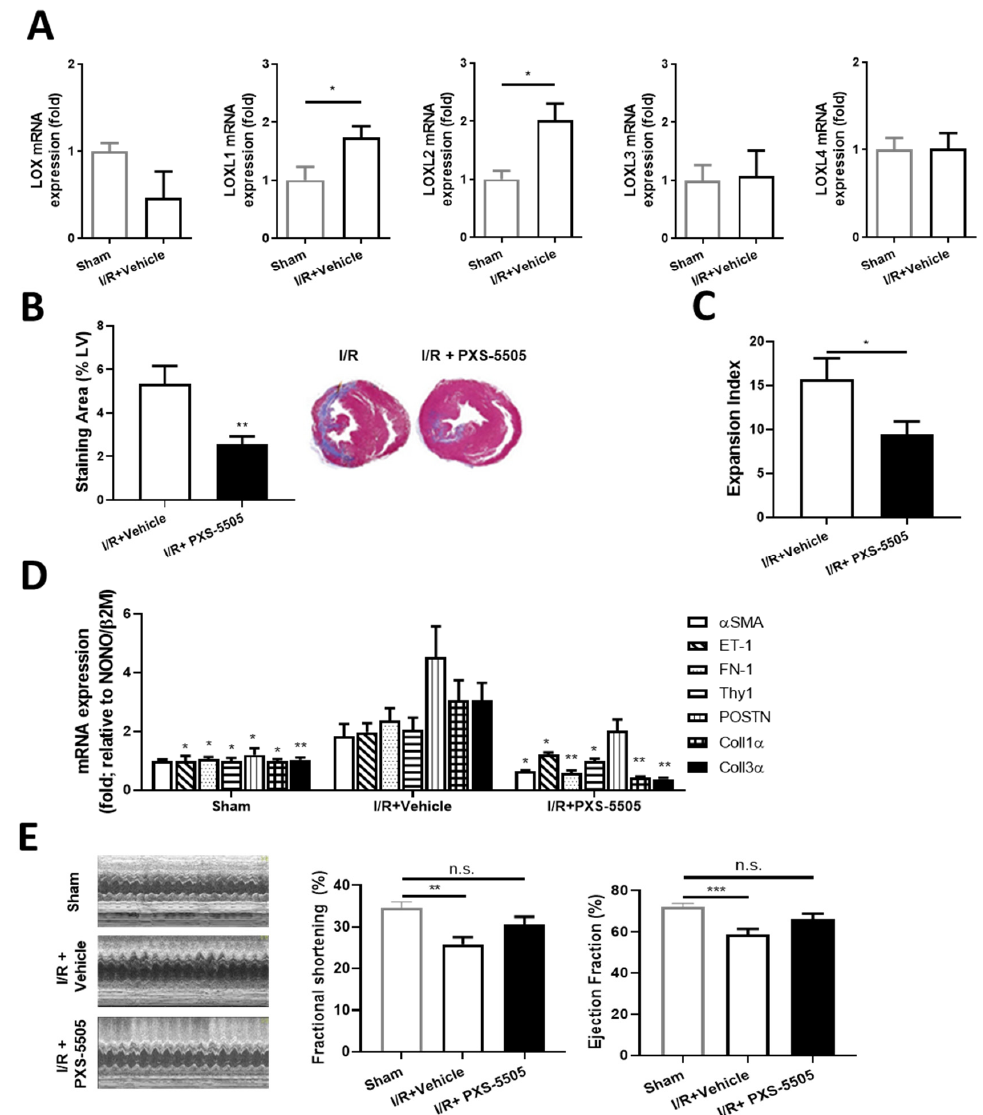
Figure 5. Effect of PXS-5505 treatment on fibrosis and heart function following ischaemia-reperfusion induced myocardial injury. ( A ) mRNA expression showing isoforms LOXL1 and LOXL2 were elevated but levels were unchanged for LOX , LOXL3 and LOXL4 in the I/R induced fibrotic rat hearts at 4 weeks post-surgical intervention. ( B ) PXS-5505 reduced fibrotic area in the rat heart subjected to I/R. Representative images of left ventricle (LV) stained with Masson’s trichrome to differentiate fibrotic tissue (blue) from muscle tissue (purple) with quantification of the staining area expressed as the percentage of the LV. ( C ) PXS-5505 reduced expansion index in the I/R heart. Measurement of expansion index, representing extent of infarct within the LV. ( D ) mRNA expression of fibrosis-related genes in rat hearts at 4 weeks post-surgical intervention were elevated in the group subjected to I/R compared to sham-operated, and returned towards normal in the I/R group with PXS-5505 treatment. The extent of mRNA expression was assessed for rat smooth muscle cell alpha actin ( α SMA ), endothelin 1 ( ET-1 ), fibronectin 1 ( FN-1 ), Thy1, periostin ( POSTN ), collagen 1 alpha ( Coll1 α ) and collagen 3 alpha ( Coll3 α ). PXS-5505 improved left ventricular function subjected to I/R. ( E ) Left ventricular function was assessed by echocardiography to measure the LV end-systolic diameter and LV end-diastolic diameter. The mean measurements of three independent recordings performed in triplicate for each rat were used to calculate fractional shortening and ejection fraction. (* p < 0.05, ** p < 0.01, *** p < 0.001 vs. the control I/R cohort or between the indicated groups).